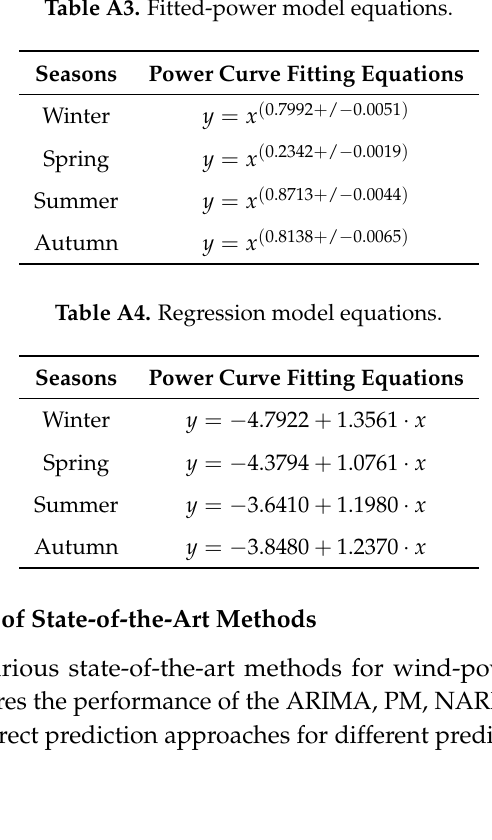
Table A3. Fitted-power model equations.